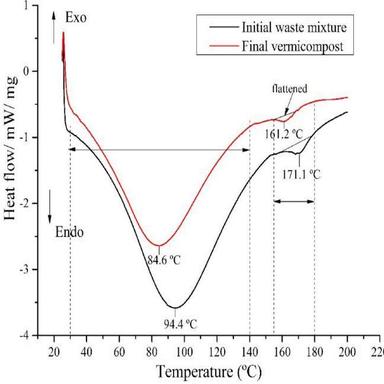
Differential calorimetry curve of the initial feed mixture and final vermicompost.